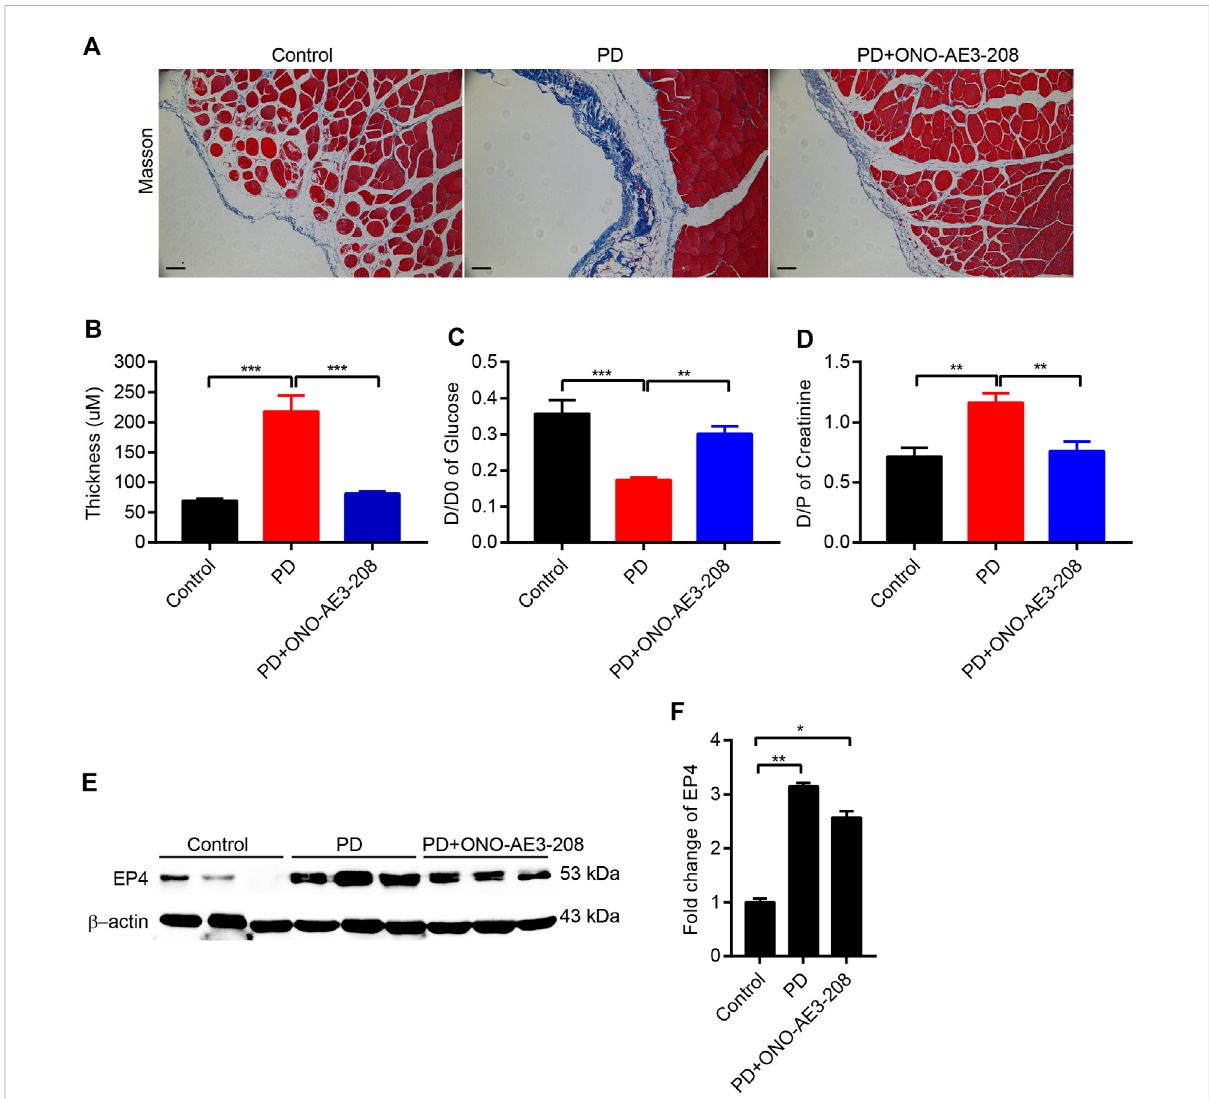
FIGURE 4 AdministrationofONO-AE3-208reducedperitonealpathologicinjuryandimprovedperitonealdysfunctioninaratmodelofperitoneal fi brosis. (A) PhotomicrographsillustratingMassonstainingoftheparietalperitoneumineachanimalgroup. (B) Thicknessoftheperitonealmembraneineach group. (C,D) Peritoneal function was assessed by the transfer of glucose (D/D0) and creatinine (D/P Scr ). (E) Peritoneal tissue lysates from each group were subjected to western blotting analysis with speci fi c antibodies against EP4 and β -actin. (F) Expression levels of EP4 were quanti fi ed by densitometry, normalised with β -actin, and presented as fold changes. Data are presented as mean ± SEM. * p < 0.05, ** p < 0.01, *** p <